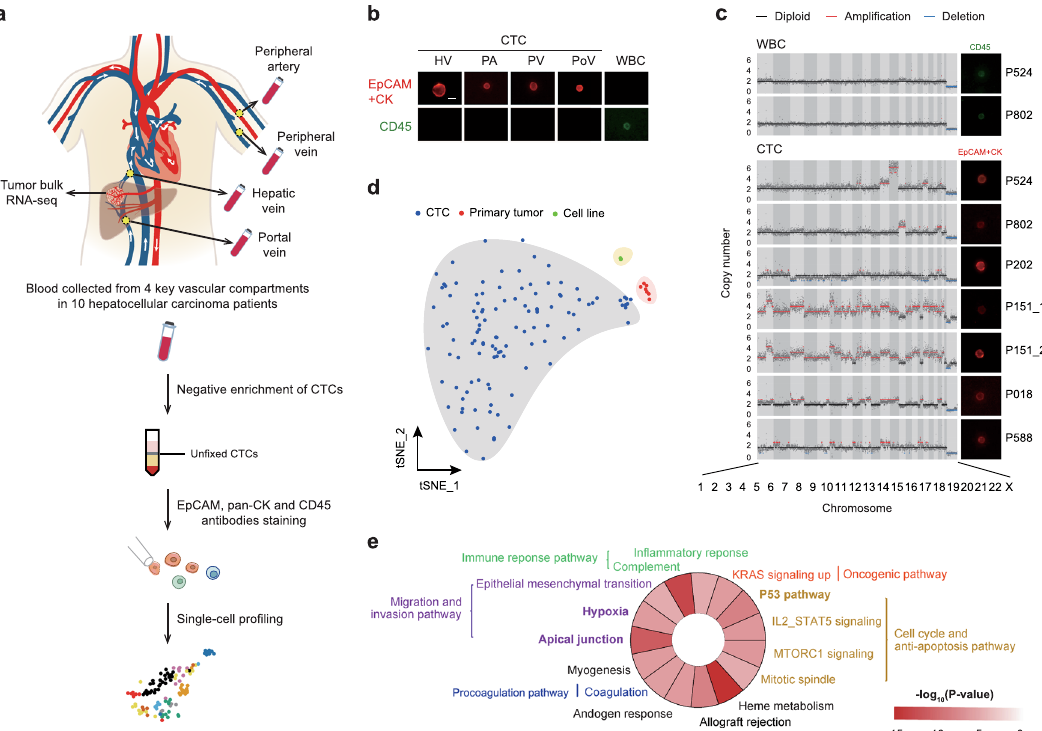
Fig. 1 Characterizing differential gene expression among CTCs, primary tumor, and HCC cell lines based on RNA-seq. a Overview of the work fl ow for CTC isolation and single-cell RNA preparation. b Representative fl uorescence images of CTCs and WBCs labeled with CD45, EpCAM, and CK antibodies; the scale bar is 10 μ m. c CNV pro fi ling of seven EpCAM + and/or pan-CK + and CD45 − CTCs and two CD45 + WBC from six patients. The fl uorescence images of sequenced CTCs and WBCs are displayed. d t -SNE plot illustrates the similarity of the expression pro fi les between CTCs, primary tumors, and HCC cell lines. e Pathway enrichment in the Hallmark dataset for upregulated genes in CTCs compared with primary tumors. Hypergeometric test was used to test whether DEGs were overlapped with the gene sets. The Benjamini – Hochberg FDR-controlling method for multiple hypothesis testing were